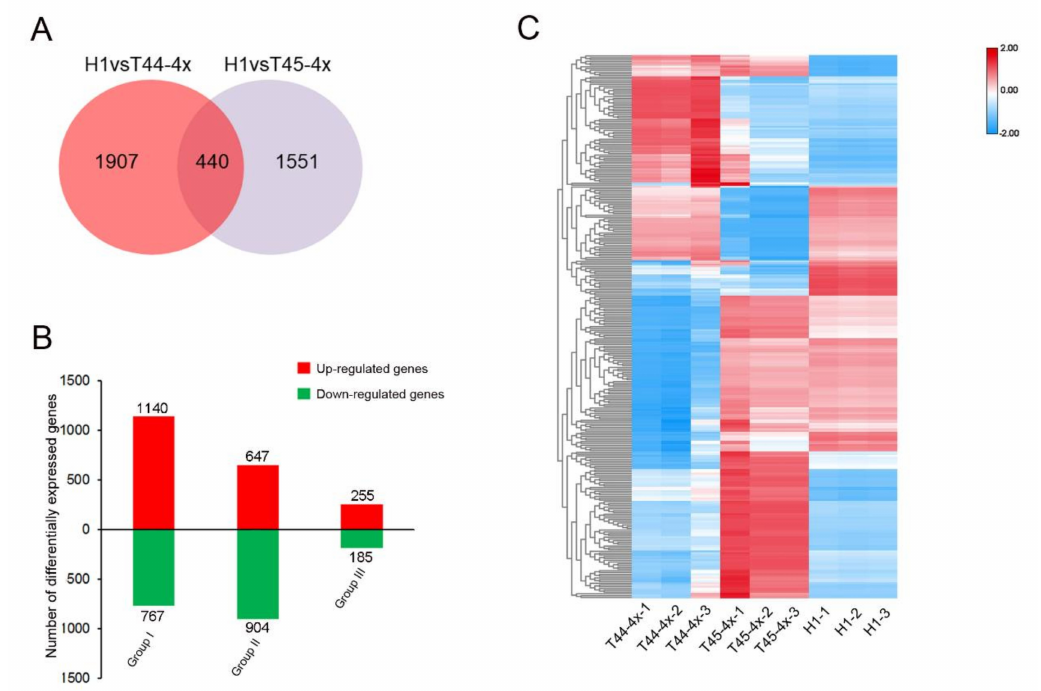
Figure 5. Di ff erentially expressed genes in meiotic anthers of H1 detected by RNA-sequencing analysis compared to its two parents. ( A ) Venn diagram of di ff erentially expressed genes in H1 detected by RNA-sequencing analysis. ( B ) Number of di ff erentially expressed genes in H1 compared to its parents. Group I refers to the DEGs of H1 derived from T44-4x; Group II refers to the DEGs of H1 derived from the T45-4x; Group III refers to di ff erentially expressed genes in H1 and its two parents. ( C ) Expression patterns of common DEGs in H1 and its two parents. Red and blue colors indicate di ff erentially expressed genes that were up- and down-regulated,